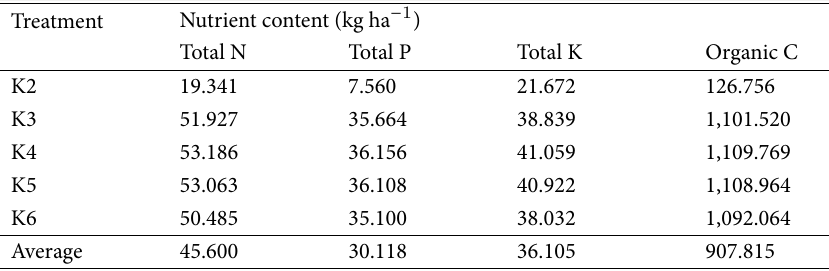
Table 1 Nutrient contributions from Azolla and duck manure in each treatment.